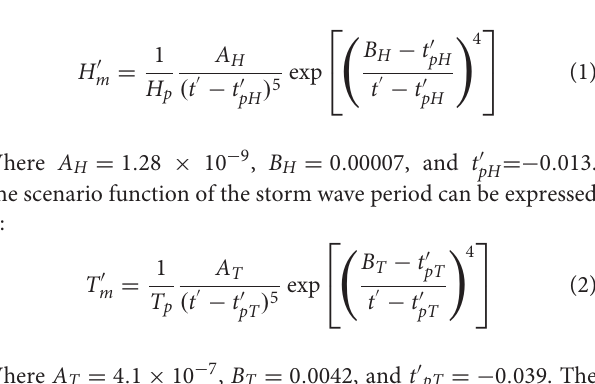
wave height affecting Maengbang Beach is expressed in terms of (cid:48) dimensionless time t , as given in Eq.